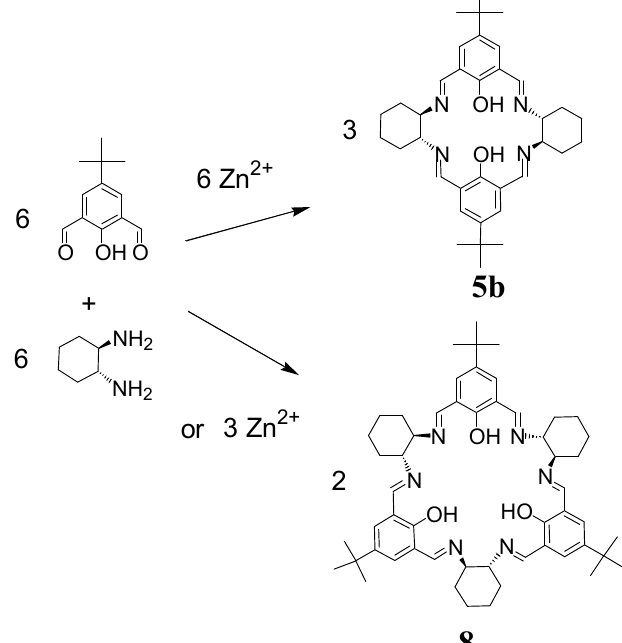
Figure 5. Dependence of the size of the macrocycle on the amount of added template.